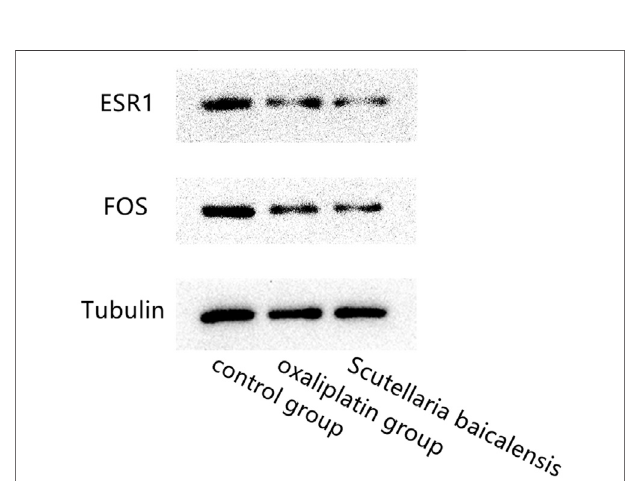
FIGURE 6 | Western blotting results show the comparison of the expression levels of ESR1, FOS and Tubulin genes in Scutellaria baicalensis group, oxaliplatin treated group and the control